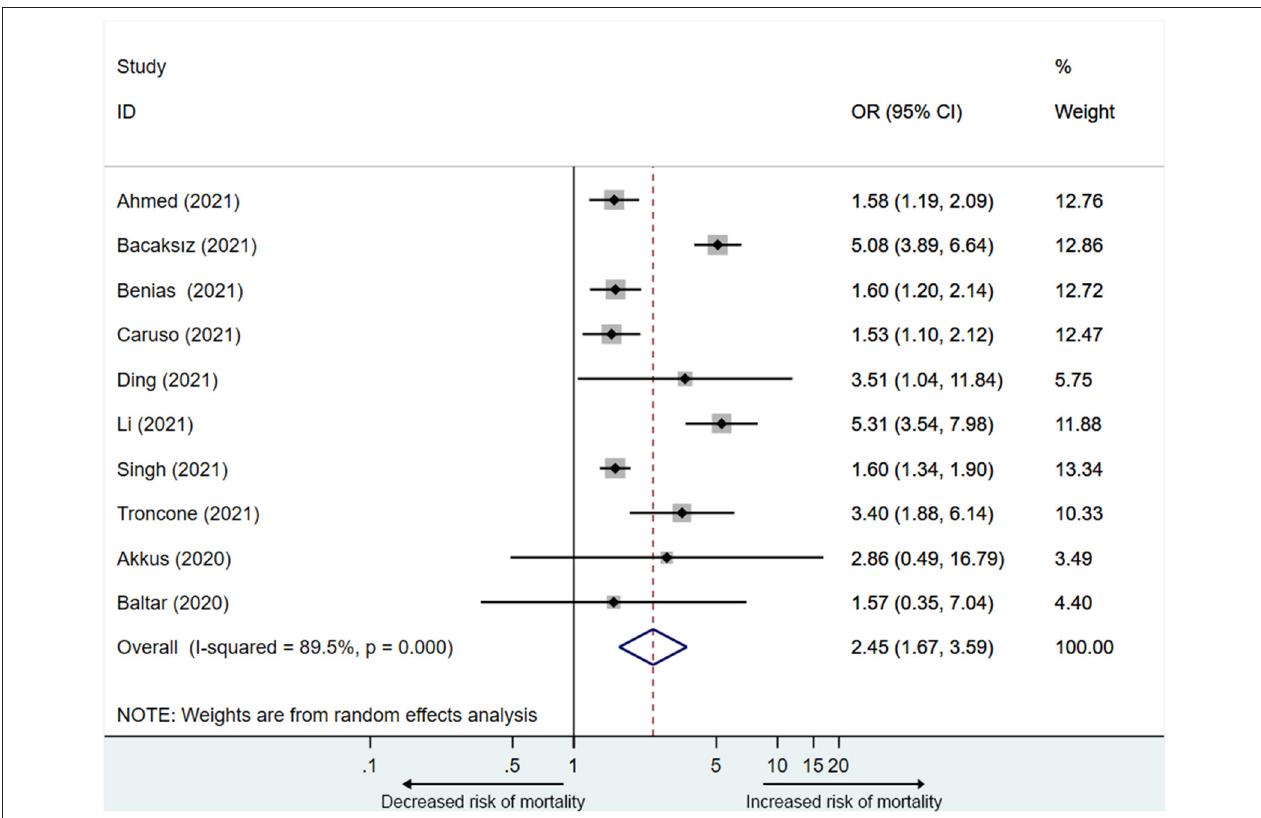
FIGURE 3 | Effect size analysis for mortality in COVID-19 patients with PE